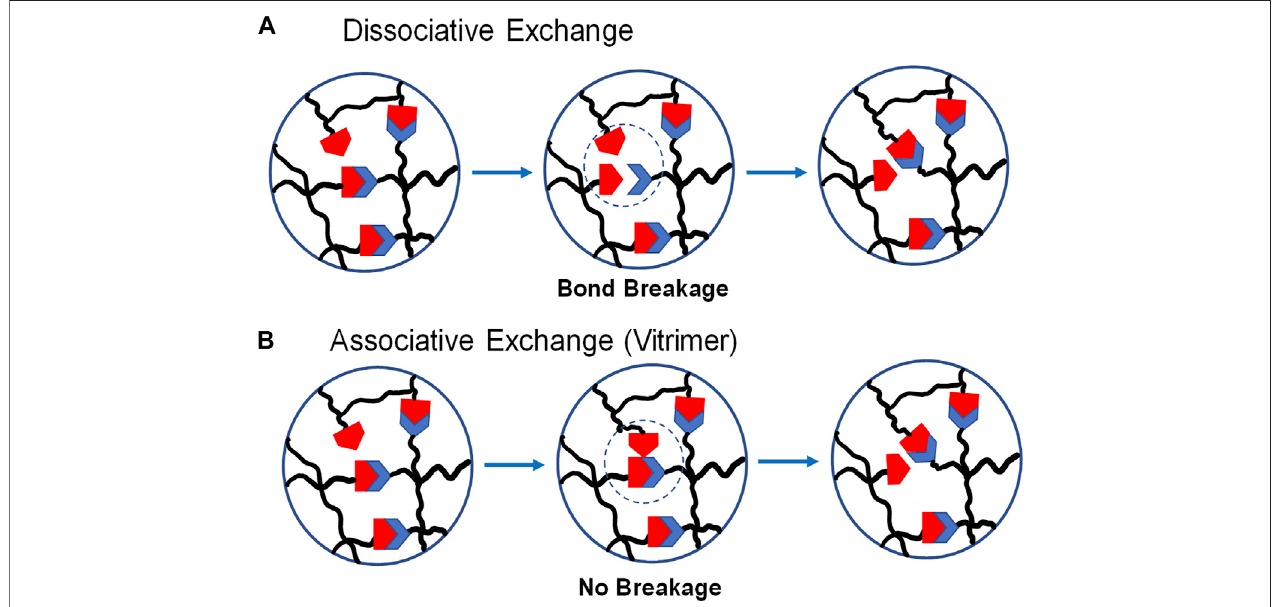
FIGURE 2 | Characterization methods for covalent adaptable networks including chemical, thermal, and reprocessing techniques.